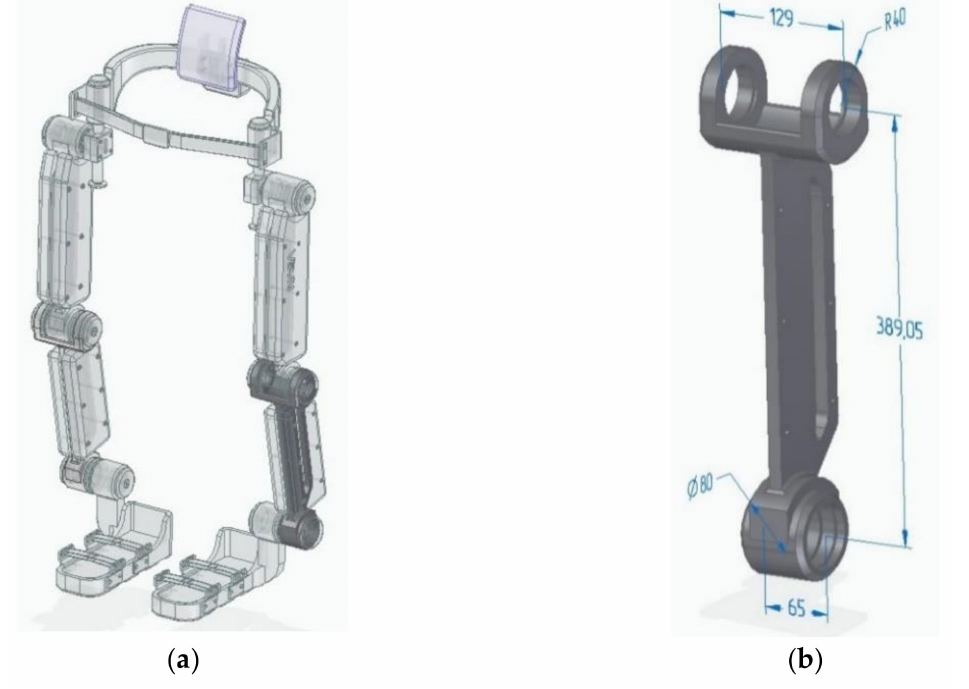
Figure 1. NASA exoskeleton model: ( a ) Lever highlighted in exoskeleton assembly; ( b ) Model of an exoskeleton